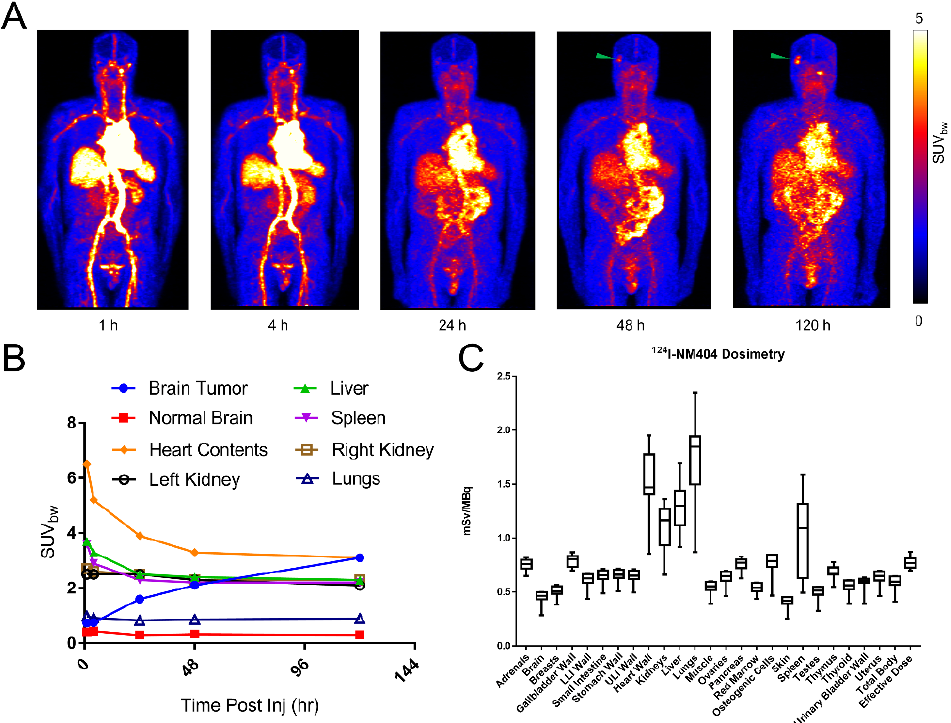
Figure 6. Longitudinal biodistribution and dosimetry estimations of [ 124 I]I-NM404. ( A ) Maximum intensity projections (MIP) of standard uptake value normalized by body weight (SUV bw ) at 1, 4, 24, 48 and 120 h for a patient with unsuspecting brain metastases (same as patient depicted in Figure 1). The green arrows at 48 h and 120 h indicate intense signal in the head region indicative of brain metastases. ( B ) The mean SUV bw of the brain metastases and various organs of interest are plotted over time to show the biodistribution of [ 124 I]I-NM404within this patient. Notice how the SUV bw of the brain metastases increases continually during the longitudinal imaging. ( C ) Semiquantitative organ dosimetry estimations (mSv/MBq) are shown as box plots for [ 124 I]I-NM404 in patients with a wide variety of solid primary and metastatic malignancies ( n = 14). Whiskers indicate the minimum and maximum values.